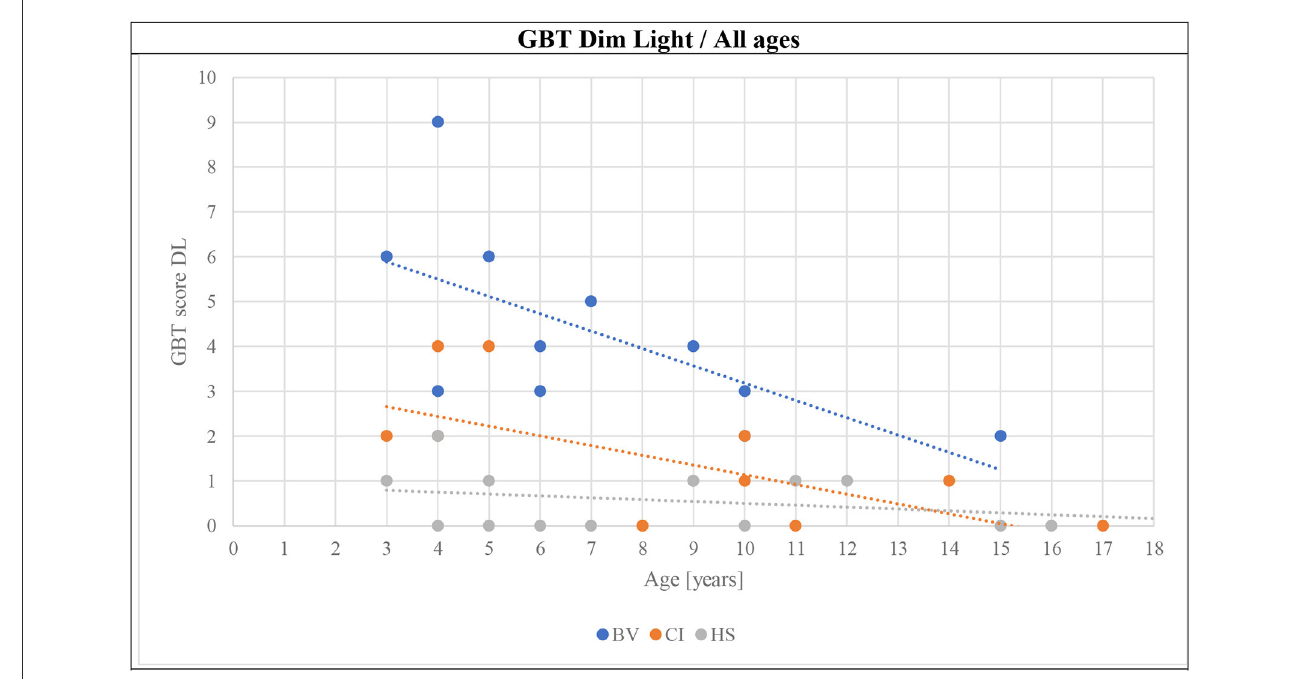
FIGURE7 Evolution of the GBT scores of all subjects in DL conditions as a function of age (BV, blue symbols; CI, orange symbols; HS, gray symbols).